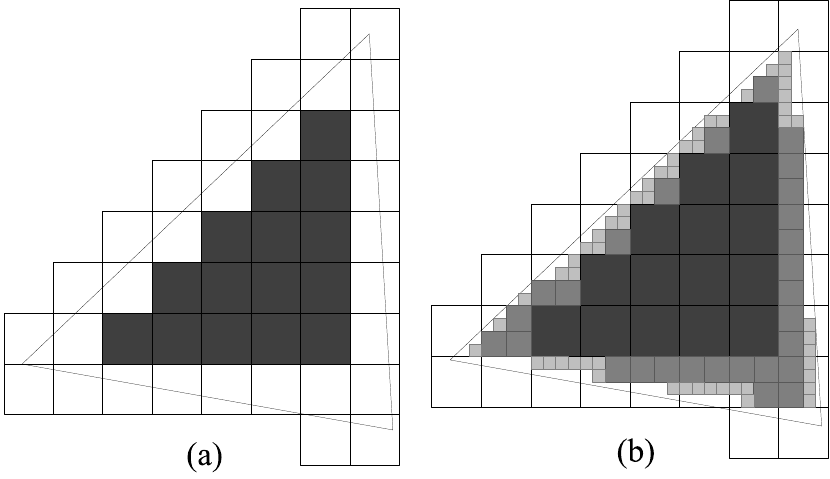
Figure 2. ( a ) The conventional SBR algorithm. ( b ) The multiresolution grid algorithm.